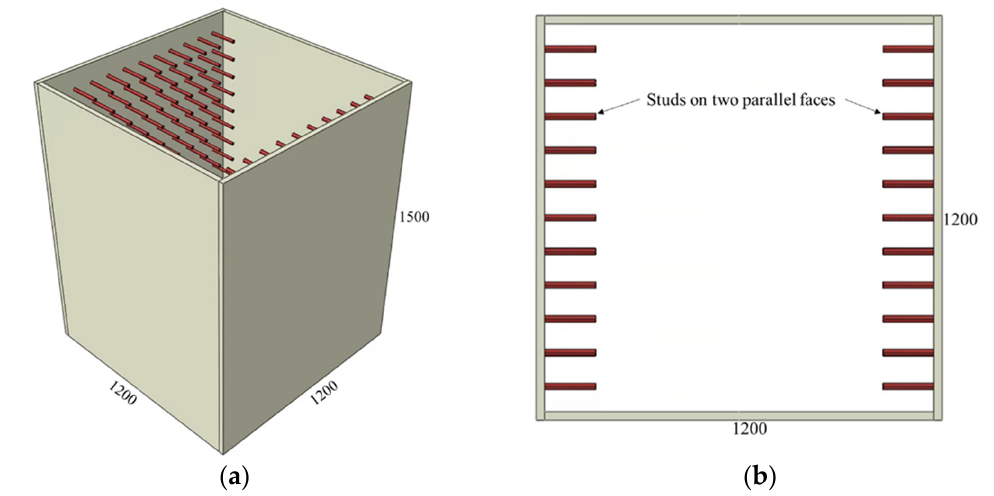
Figure 3. CFST column with shear studs on two parallel faces: ( a ) 3D view and ( b ) top view.